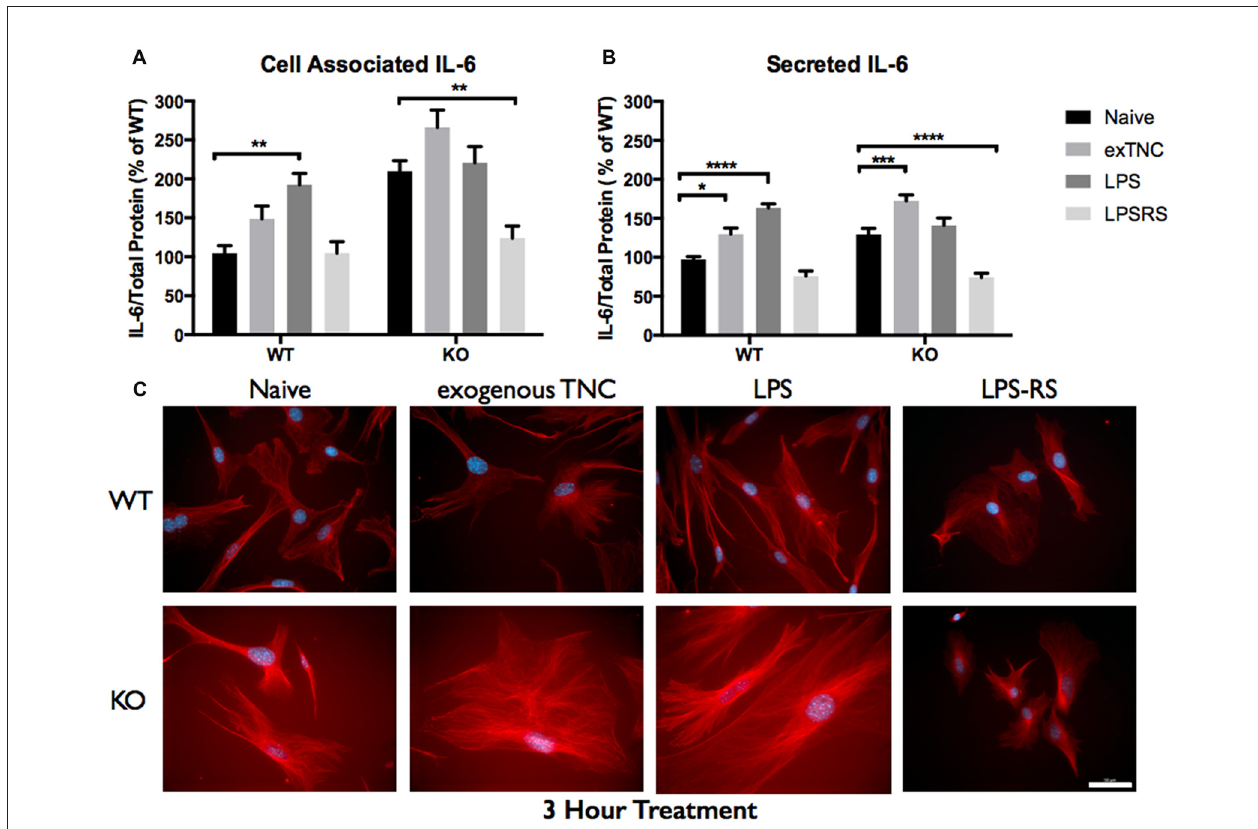
FIGURE 5 | Secreted IL-6 expression post a 3-h treatment is significantly altered following TLR4 activation. (A) Cell associated astrocyte expression of IL-6 in WT ( n = 6/group) and FMR1 KO ( n = 6/group) astrocyte cell cultures grown for 7 days in vitro . The culture was treated with lipopolysaccharide (LPS; 10 µ g/mL), exogenous TNC (10 µ g/mL) and LPS-RS (10 µ g/mL) for 3 h prior to collection. Representative bands were normalized to the total protein and expressed as a percentage of the average IL-6 in the WT group. Statistical differences denoted with a double asterisk, P < 0.01. (B) Extracellular astrocyte expression of secreted IL-6 in WT ( n = 6/group) and FMR1 KO ( n = 6/group) astrocyte cell cultures grown for 7 days in vitro . The culture was treated with LPS (10 µ g/mL), exogenous TNC (10 µ g/mL) and LPS-RS (10 µ g/mL) for 3 h prior to ACM concentration and collection. Representative bands were normalized to the total protein and expressed as a percentage of the average IL-6 in the WT group. Statistical differences denoted with a single asterisk, P < 0.05, with a triple asterisk, P < 0.001 and with four asterisks, P < 0.0001. (C) Cultured cortical astrocytes co-labeled with DAPI (blue) and anti-IL-6 (red) after 3 days in vitro , following a 3 h treatment. Images